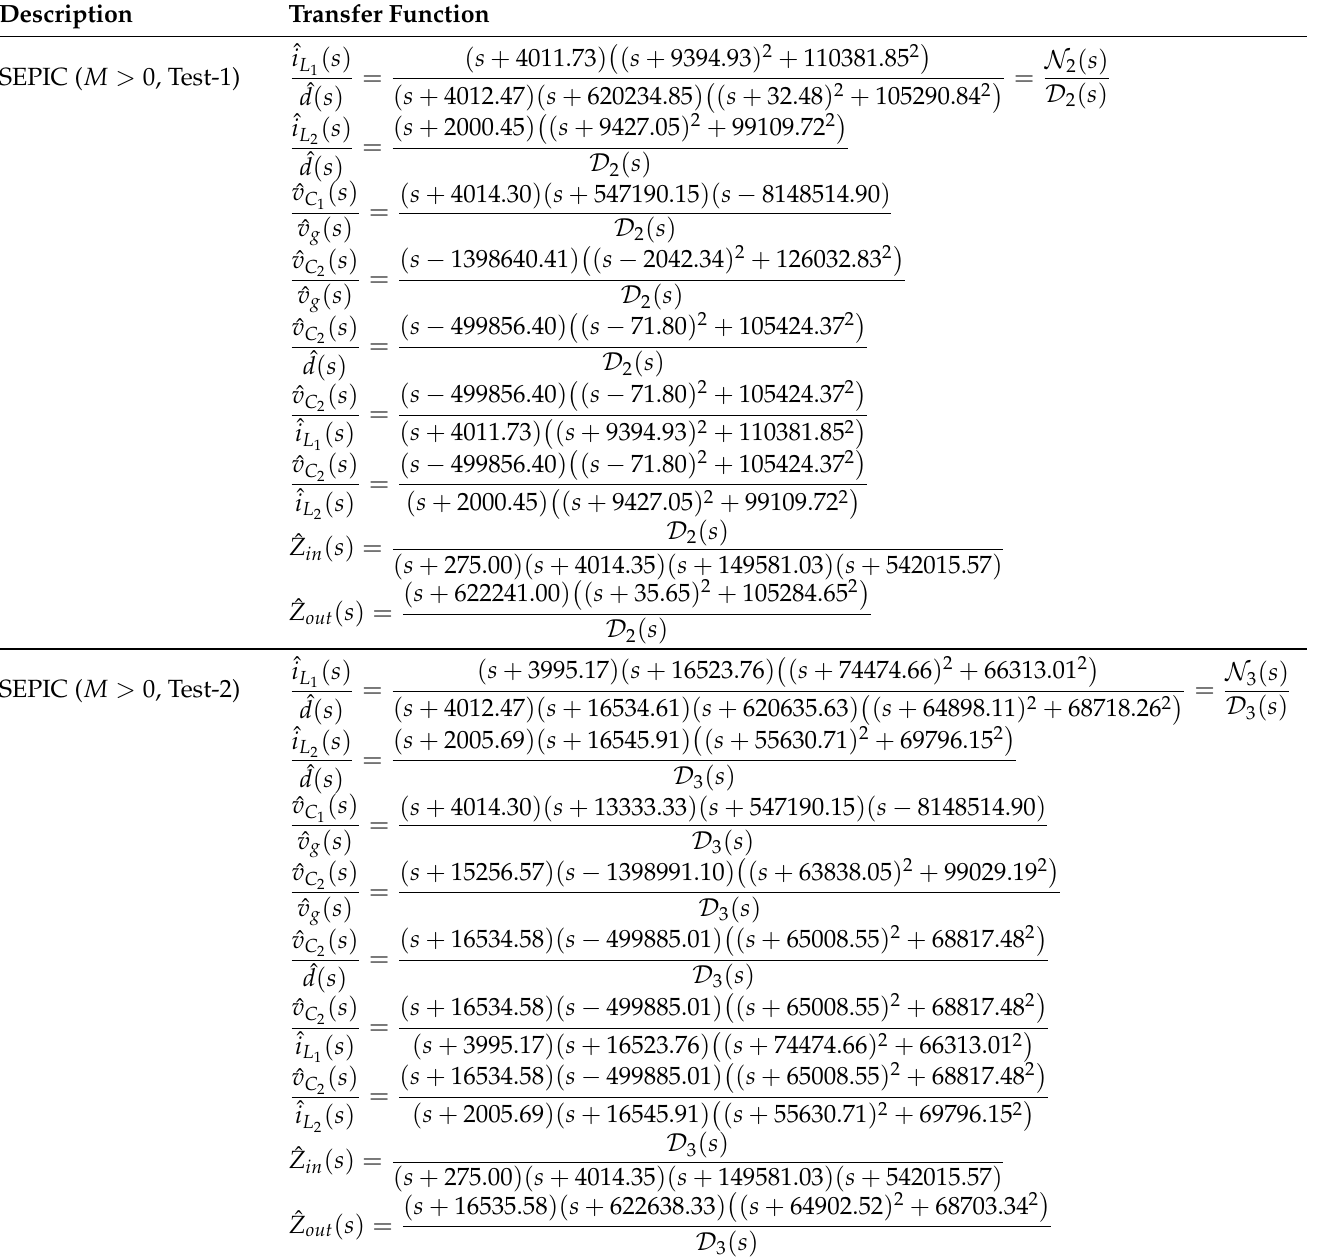
Table 6. Theoretical transfer functions of the SEPIC converter under the tests conditions depicted in Table